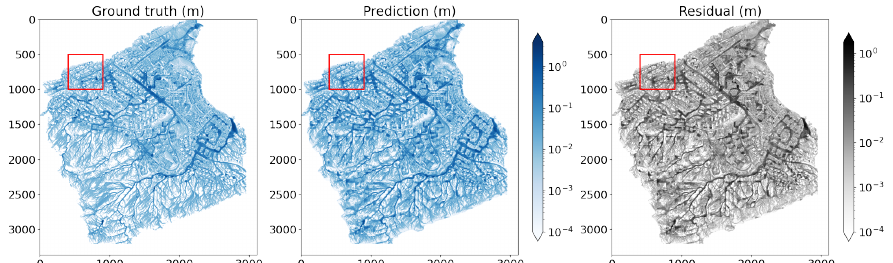
Figure A2. Ground truth maximum water depth and prediction for Zurich catchment and rainfall event tr2_1 , with bounding box depicting the patch area shown in ( b ).